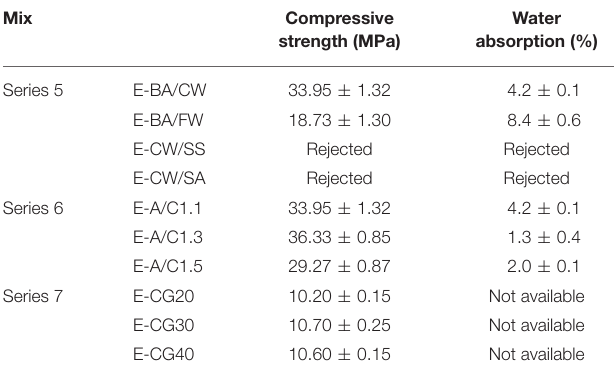
TABLE 5 | Compressive strength and water absorption